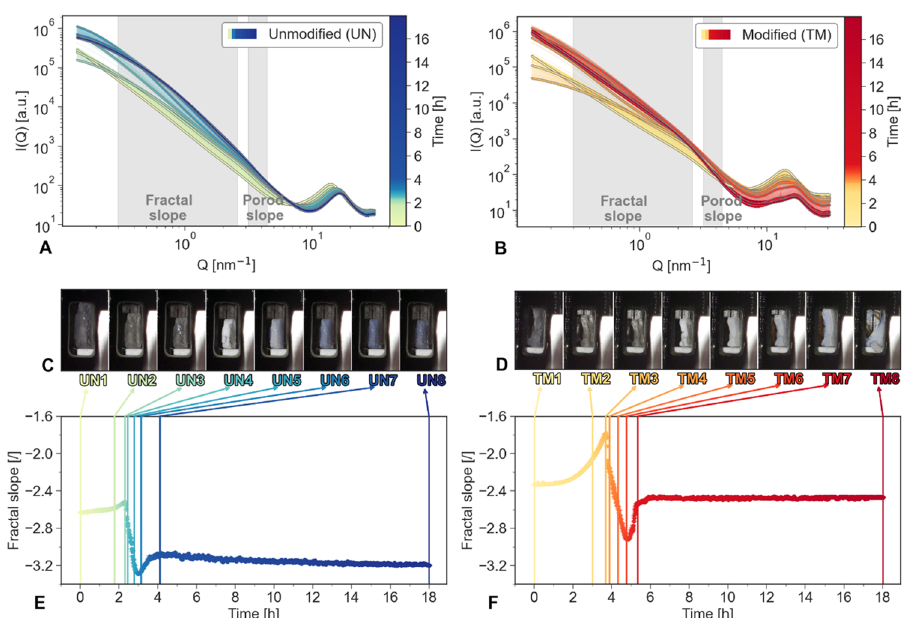
Figure 3. ( A , B ) Small-angle X-ray scattering (SAXS) diagrams of the unmodified UN (green/blue) and modified TM (yellow/red) samples over the duration of the drying. Specific measurements are highlighted by a grey stroke. ( C , D ) Selected photographs according to noticeable changes in fractal slope for both samples UN and TM. ( E , F ) Slope fits for the fractal slope for the duration of the experiment of UN (green/blue) and TM (yellow/red)